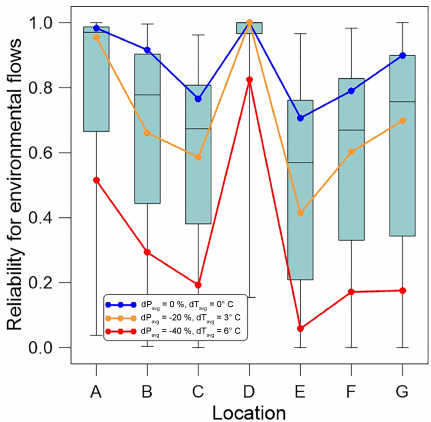
Figure 5. Reliability against the instream flow requirements at the seven locations obtained from the 539 sequential optimizations with stress-induced weather series. The blue, grey, and red lines connect the reliabilities at the seven locations under the three representative climatic stresses.